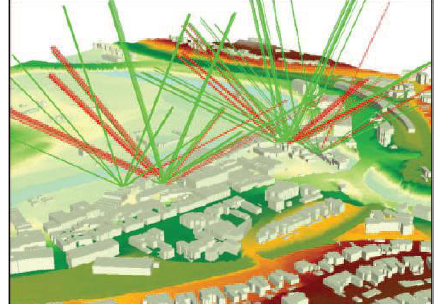
Figure 3. LOS of GPS satellite visibility (Taylor et al., 2007)